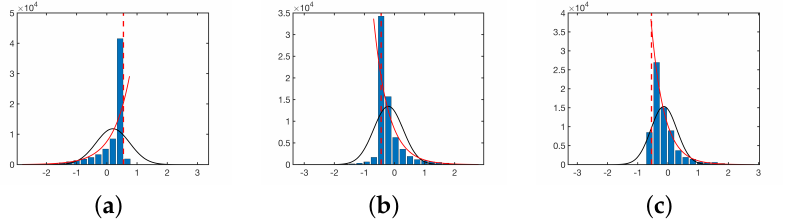
Figure 4. Histograms of the distribution of the number of cluster elements depending on the values (cid:12) (cid:12) of parameters ( a ) ∂ρ , ( b ) ∂ρ , and ( c ) s relative to their averages. The horizontal intervals show the (cid:12) ∂ z ∂ (cid:126) n H deviation from the mean in units of standard deviation, the vertical axis shows the number of sample elements in thousands. The red dotted line shows the shift of the mean relative to the zero value of the parameters. For comparison, the black solid line shows the corresponding normal distribution, and the red solid line shows the exponential distribution.